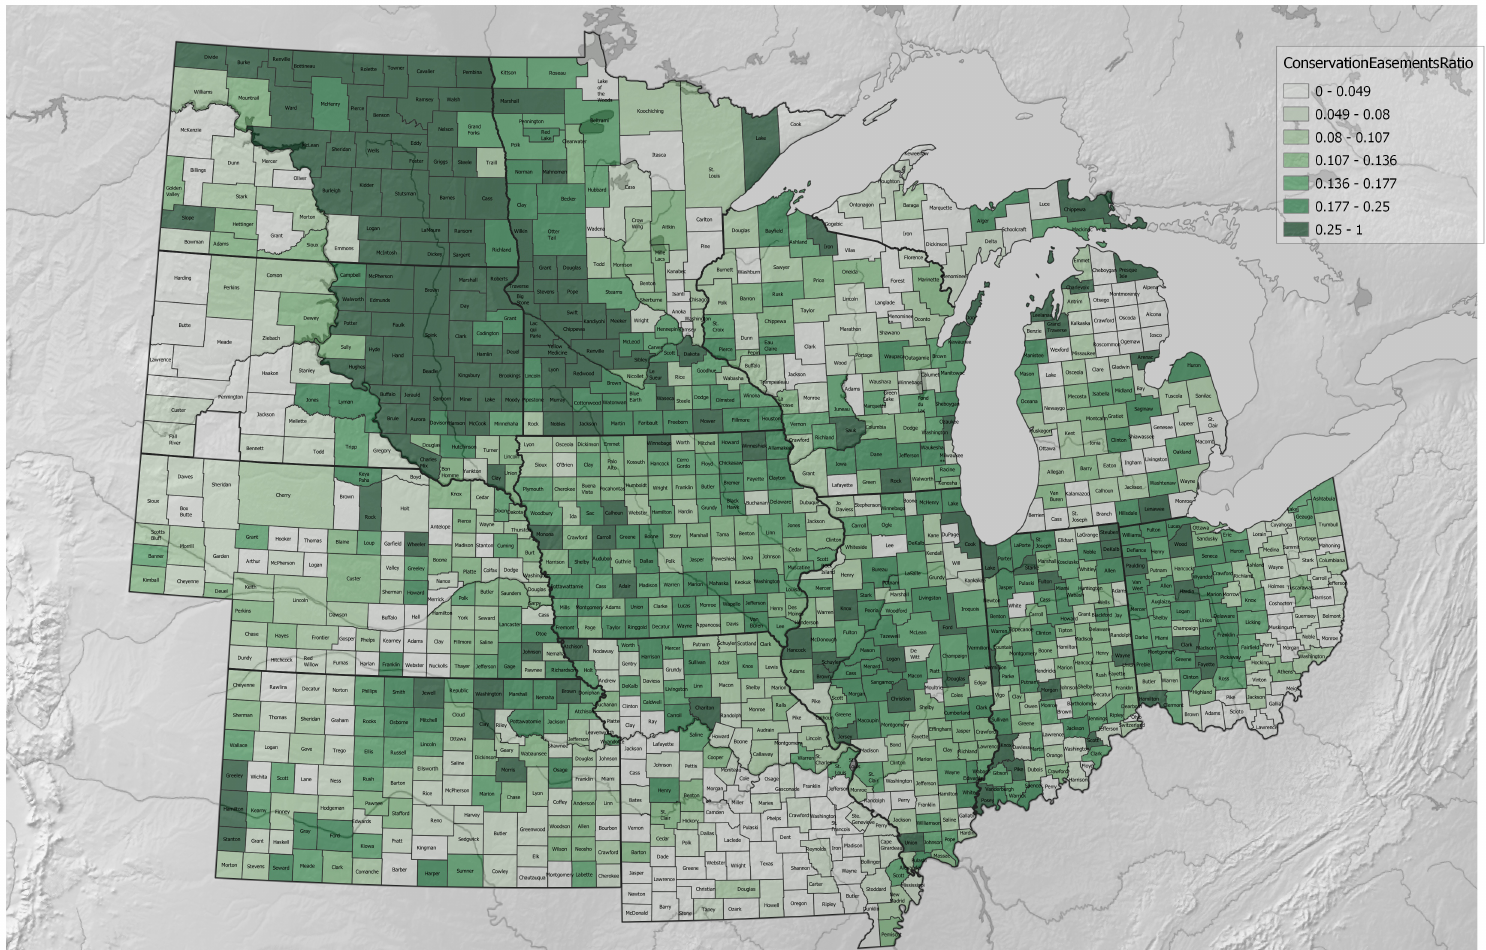
Figure A4. Fraction of farms with conservation easements, by county, 2017. Values were all rescaled through dividing by the largest value present for any of the counties included here (0.178 in Towner County, North Dakota), as this transformation was applied to the variable data as they were placed into the index expression. Methods for ConservationEasementsRatio are described in the article main text and Supplementary Materials. USDA 2017 Census of Agriculture data [52] were